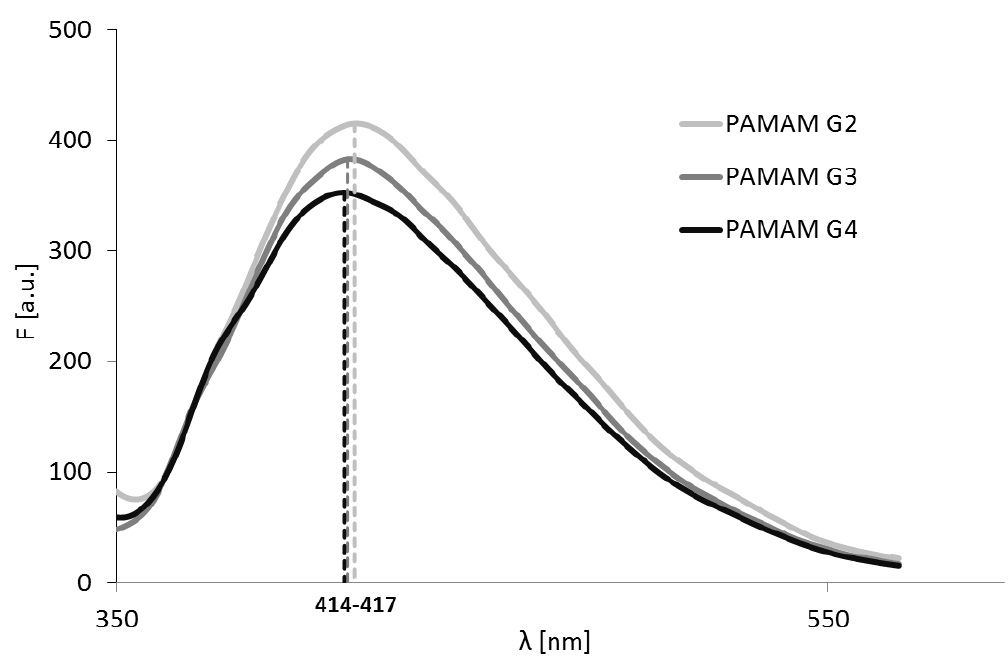
Figure 1. Emission spectra of PAMAM dendrimers (c = 1 mmol/L). λ exc = 333 nm, 330 nm, and 334 nm for PAMAM G2, PAMAM G3, and PAMAM G4, respectively.